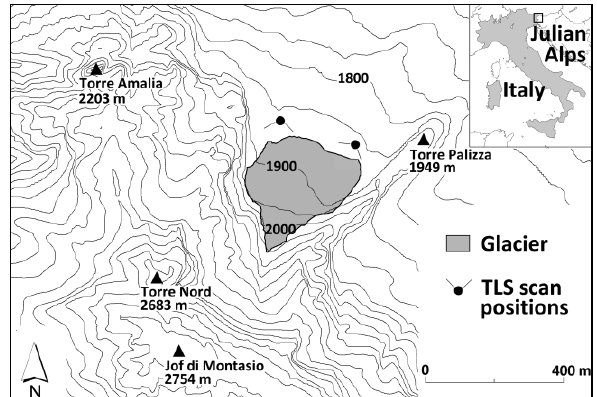
Figure 1. Geographic setting of Montasio Occidentale glacier. Repeat high-resolution TLS scanning were carried out from 2010 to 2012 on the Montasio Occidentale catchment to evaluate the mass balance of the glacier, the surface velocity fields, the debris cover dynamics and the effects of meteorological extremes (e.g. strong precipitation events, strong heat waves, heavy avalanche activity). A combined approach was used combining TLS and differential